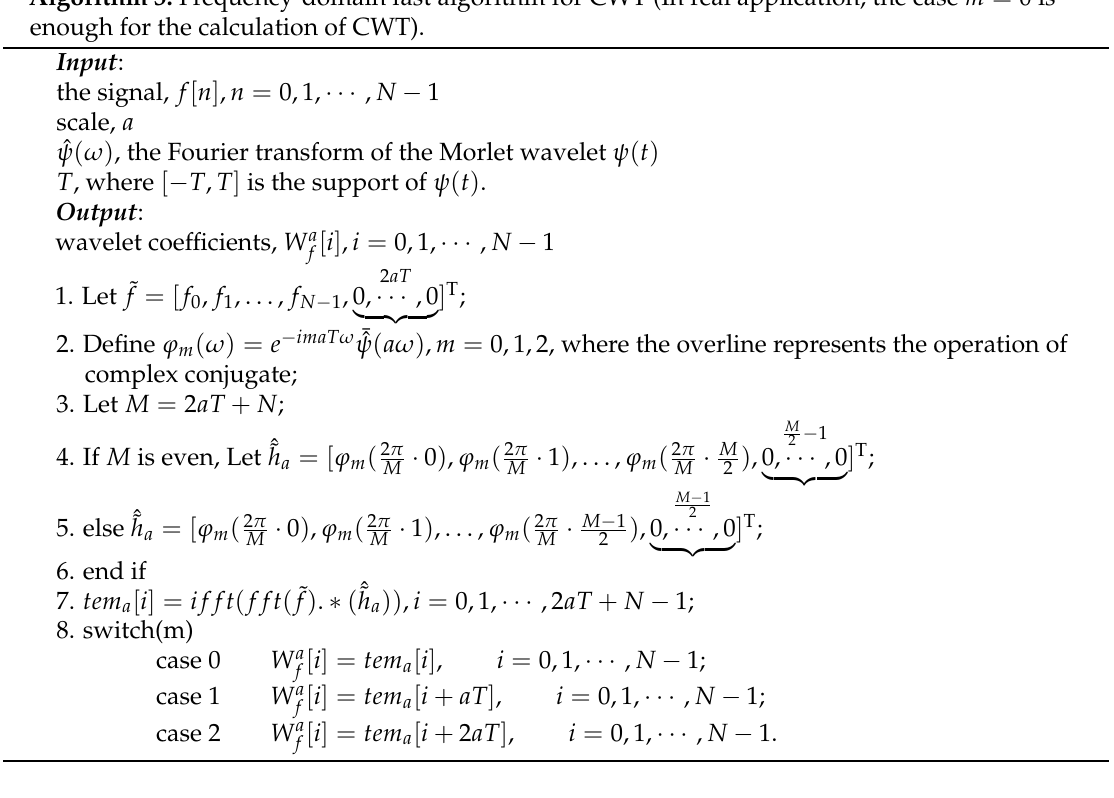
Algorithm 3: Frequency-domain fast algorithm for CWT (In real application, the case m = 0 is enough for the calculation of